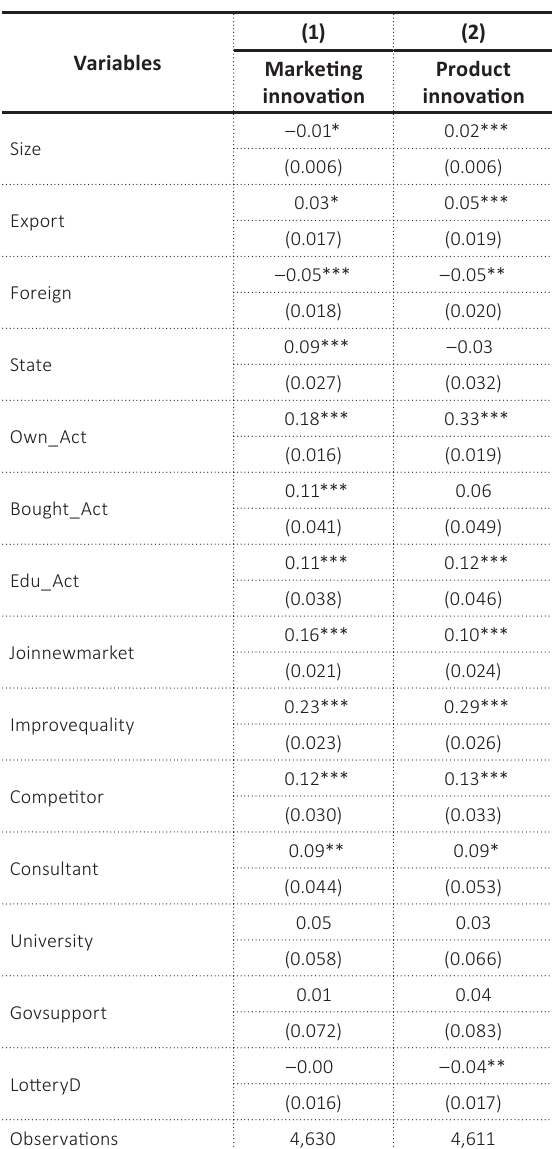
Table 2. Determinants of innovation